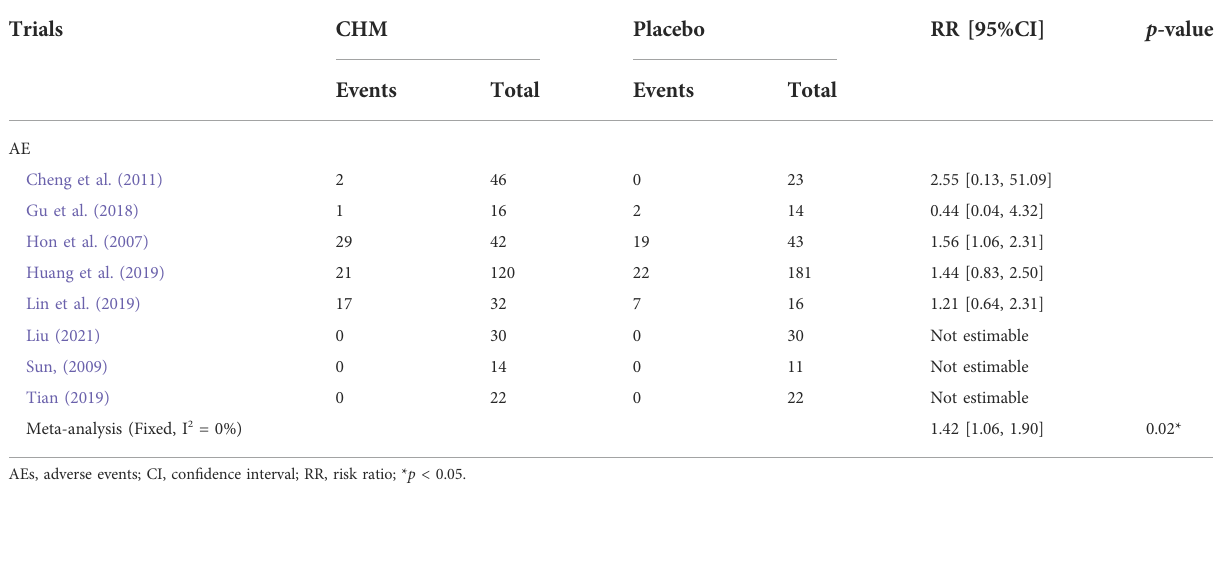
TABLE 5 All reported adverse events.